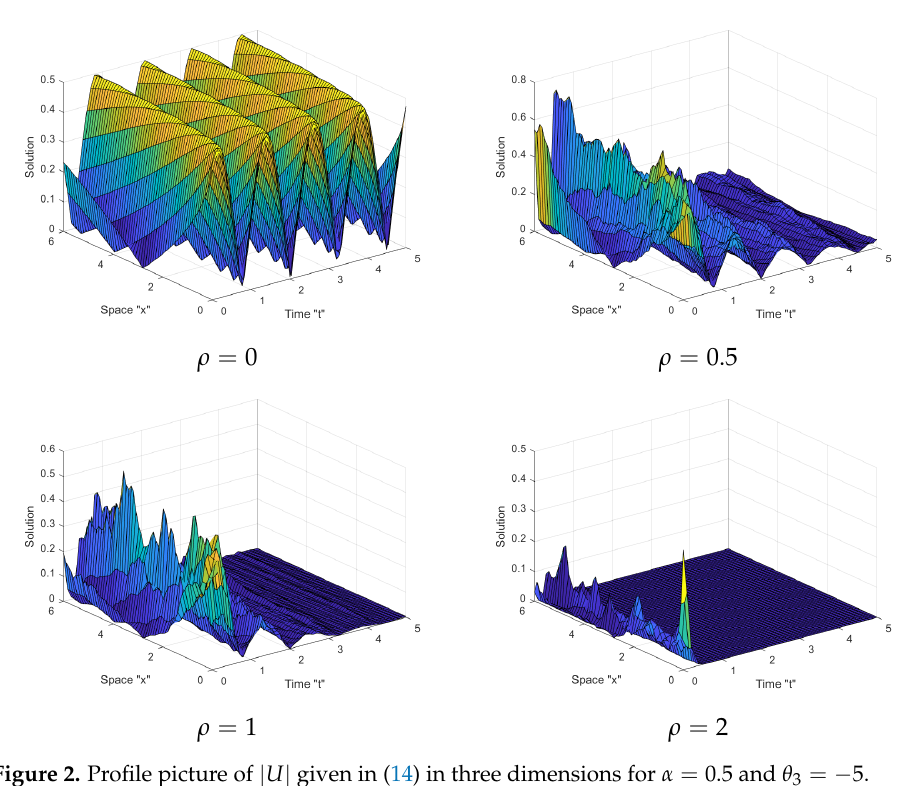
Figure 2. Profile picture of | U | given in (14) in three dimensions for α = 0.5 and θ 3 = − 5.